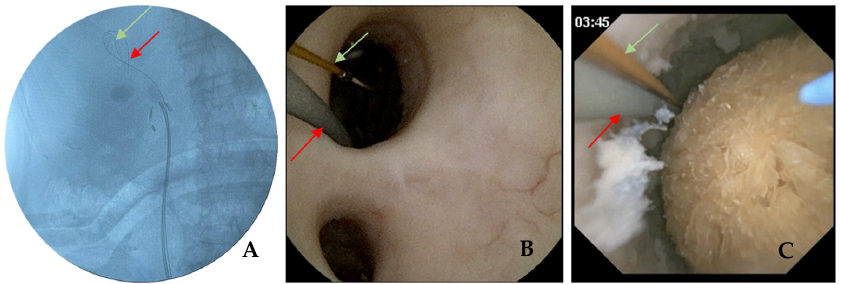
Figure 2. Pressure wire placement intro renal pelvis: ( A ) fluoroscopic image of PressureWire (green) and safety wire (red) in the renal pelvis. ( B ) Endoscopic vision of the renal pelvis with a PressureWire (green) and safety wire (red) going inside the upper calyx. ( C ) Endoscopic vision before starting lithotripsy of a dihydrate calcium oxalate stone with a safety wire (red), PressureWire (green) and fibre laser in the renal pelvis.